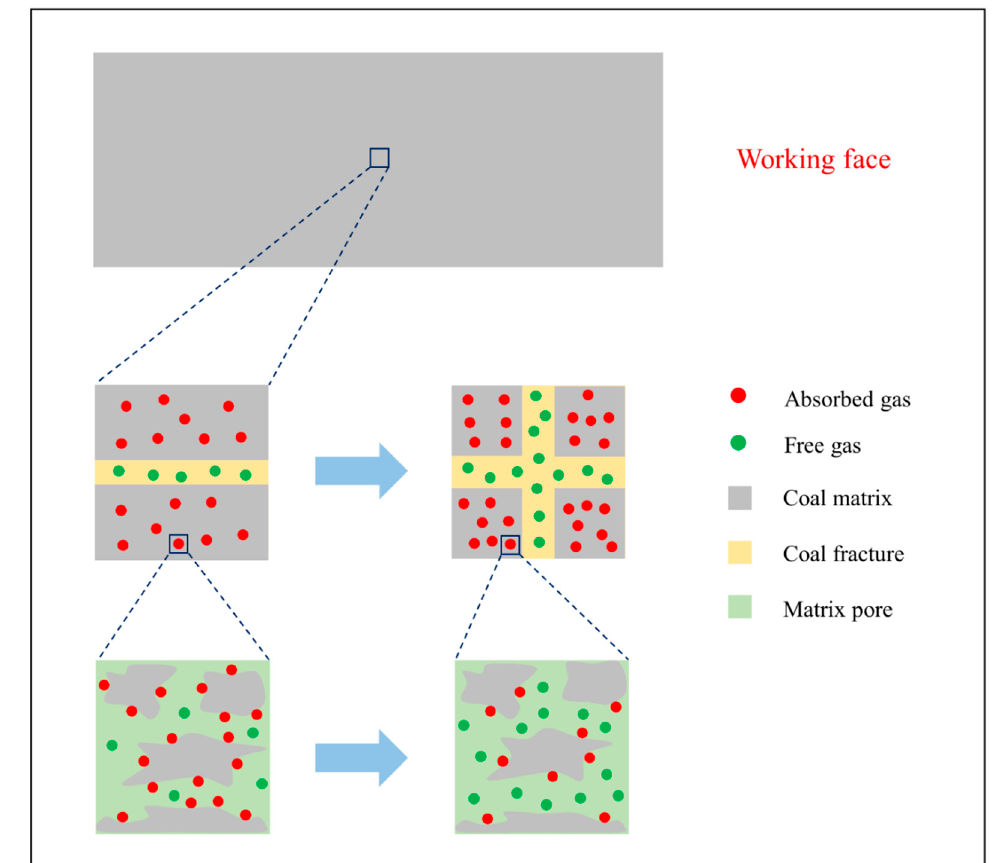
Figure 9. Schematic diagram of the coal thermal system.